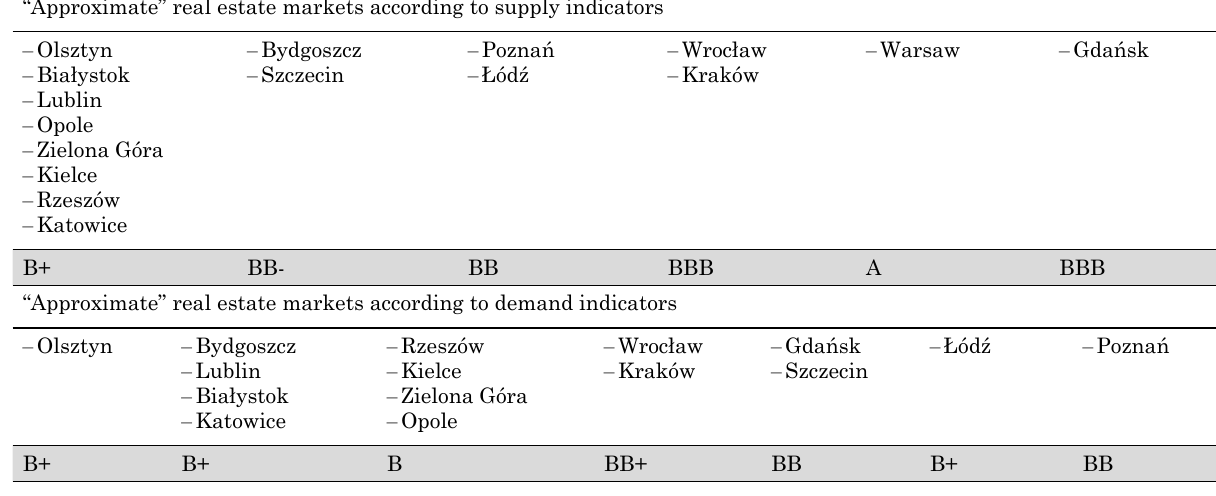
Table 5. Final rating scores of real estate markets “Approximate” real estate markets according to supply indicators